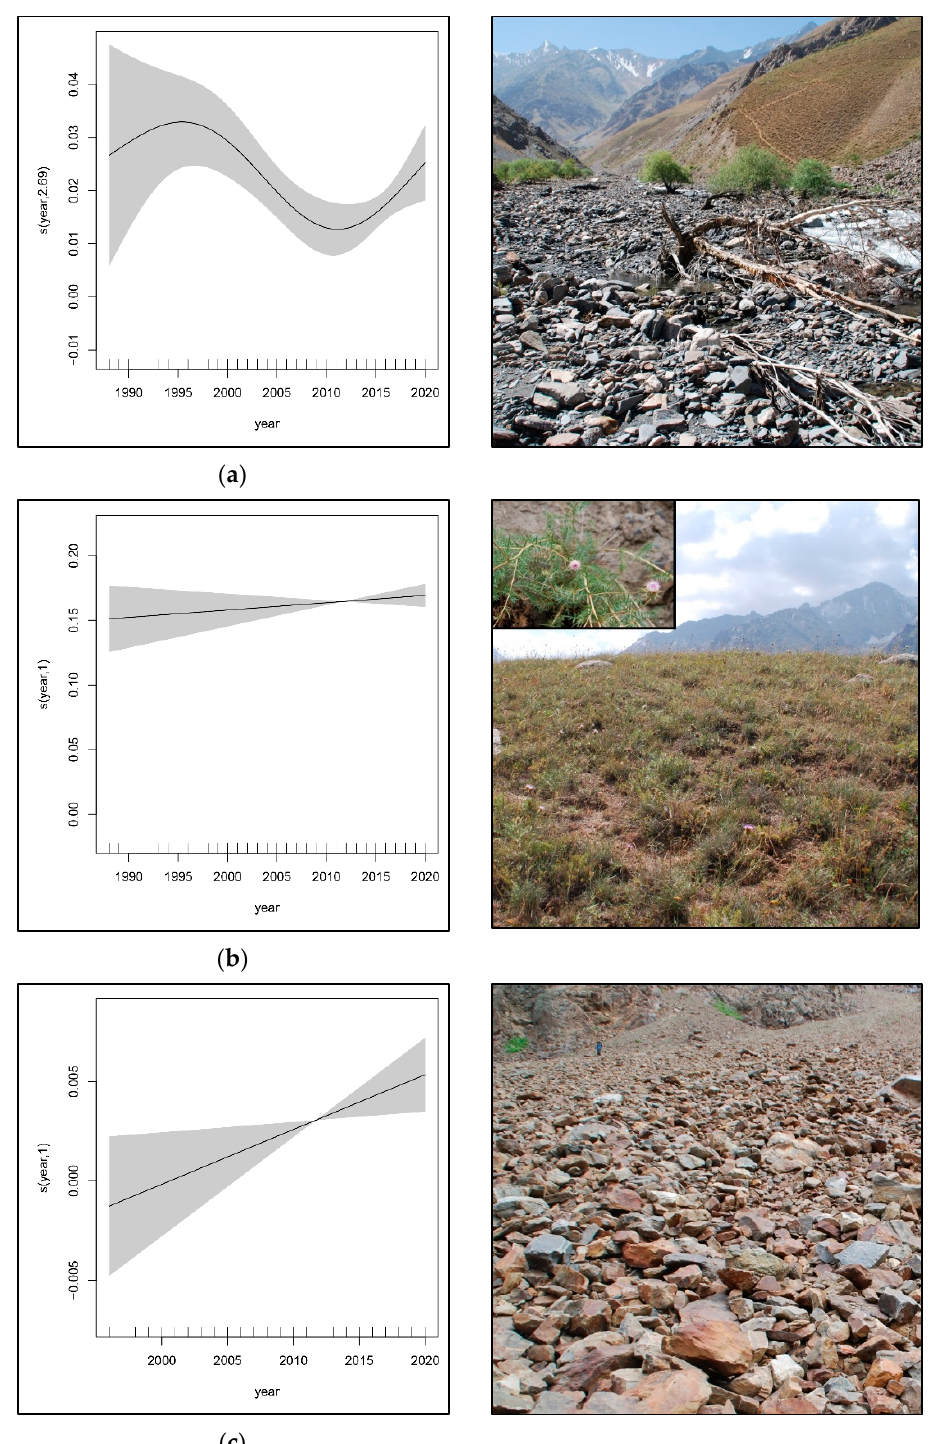
Figure 10. Illustrative examples of partial effect plots for three selected ground ‐ truthing sites. The plots show the component effect of the variable ‘year’ on the MSAVI value. The scale of the y ‐ axis was shifted by the value of the intercept so that the plot represents the prediction of the output, assuming the other variables included in the model are at their average value. The number in the parenthesis of the y ‐ axis label gives the estimated degrees of freedom of the smooth: ( a ) a debris flow in 2011 destroyed the mountain Tugai in Red valley; ( b ) a mountain steppe site that is today dominated by prickly Cousinia plants shows no significant change in MSAVI but rather in species composition; ( c ) example site from a barren land area without any vegetation that exhibits an implausible steep increase in MSAVI.